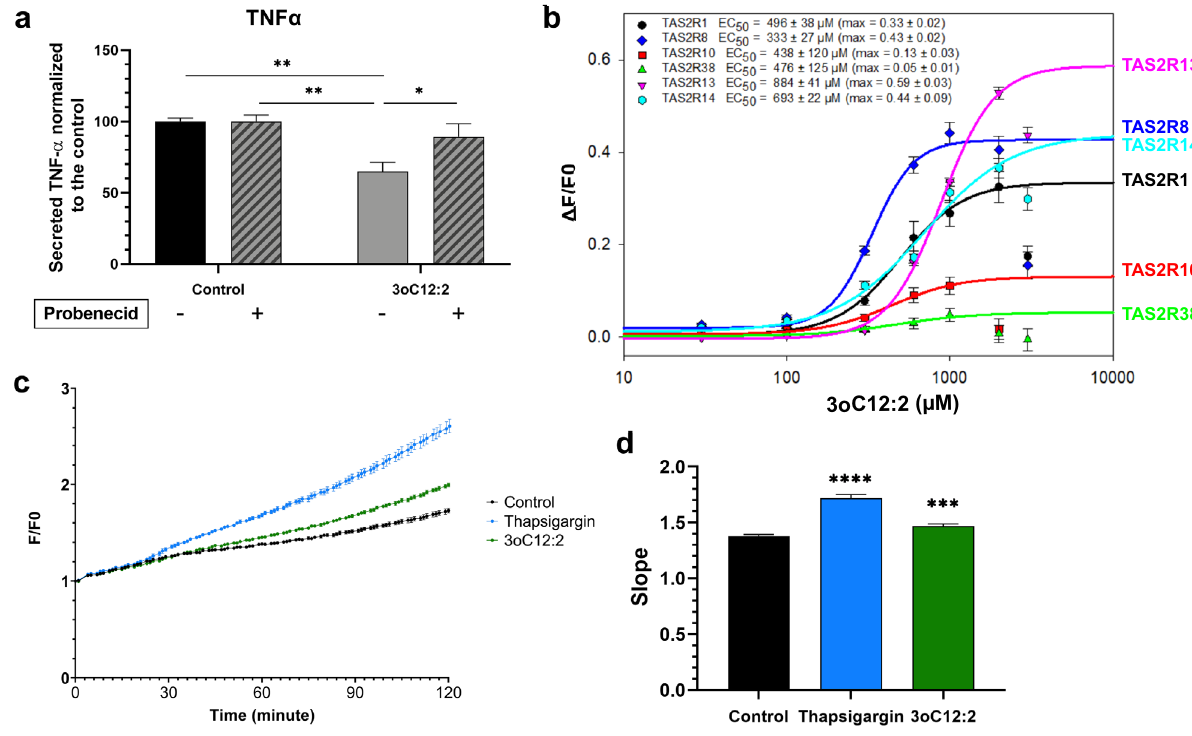
Figure 4. 3-oxo-C12:2-HSL interacts with bitter taste receptors. ( a ) RAW264.7 macrophages were pre-treated or not with 1 mM Probenecid, an allosteric inhibitor of the bitter taste receptor TAS2R138 one hour before their stimulation with LPS and IFNγ in absence (control) or in presence of 3-oxo-C12:2-HSL for six hours. Mean ± SEM from 3 independent experiments performed in triplicate, Two Way ANOVA Tukey’s post-test. ( b ) Calcium response in HEK293T cells expressing reporter human bitter taste receptor exposed to several concentrations of 3-oxo-C12:2-HSL (0–1000 µM). Fluorescence (F) was measured after exposure to the AHL and normalized to basal fluorescence (F0). Mean ± SEM from 3 independent experiments performed in triplicate. ( c ) Intracellular calcium flux in RAW264.7 cells exposed to 1000 µM 3-oxo-C12:2-HSL or 10 µM thapsigargin as a positive control or DMSO (0.5%) as a negative control. Fluorescence (F) monitoring the increase in intracellular concentration of calcium was measured for two hours and normalized to basal fluorescence (F0). Each curve is representative of 3 independent experiments of 8 replicates. ( d ) Quantification of the slope of the curves displayed in ( c ). Values are mean ± SEM of 3 independent experiments (8 replicates each). For ( a ) and ( d ): Two Way ANOVA Tukey’s post-test. *p ≤ 0.05, **p < 0.01, ***p < 0.001, ****p < 0.0001 vs. control. 3oC12:2 stands for